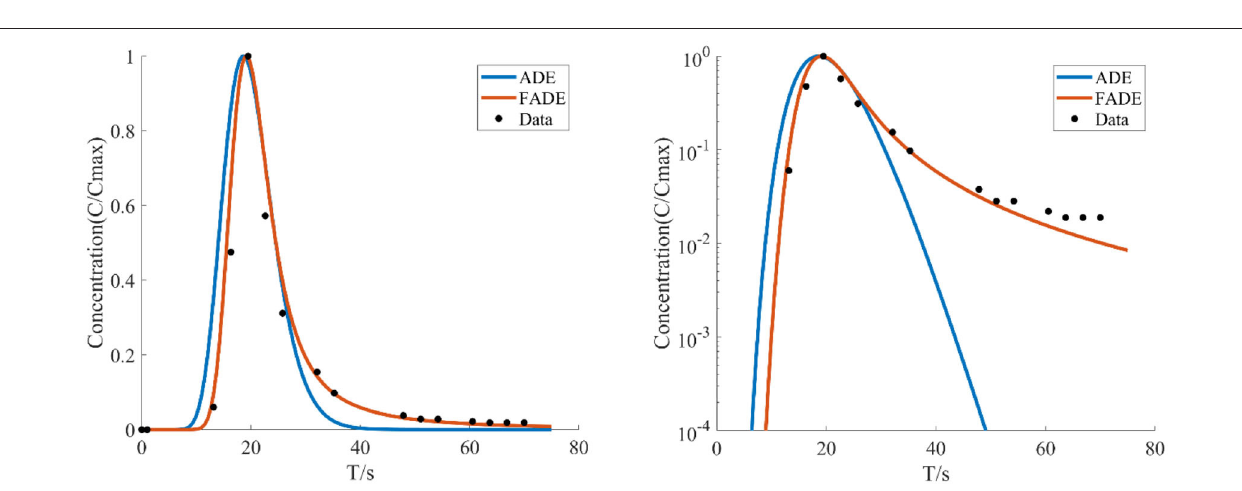
Frontiers in Physics |